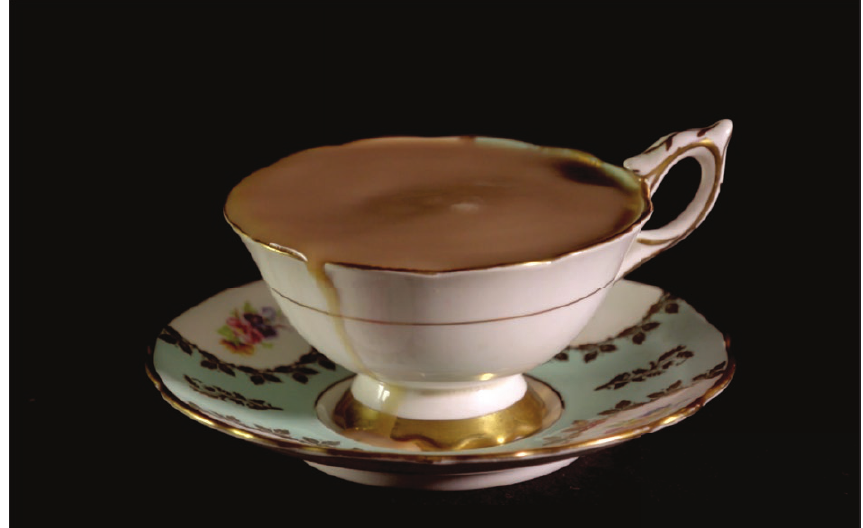
Figure 10: Farheen Haq, Drinking from my mother’s saucer, digital video,